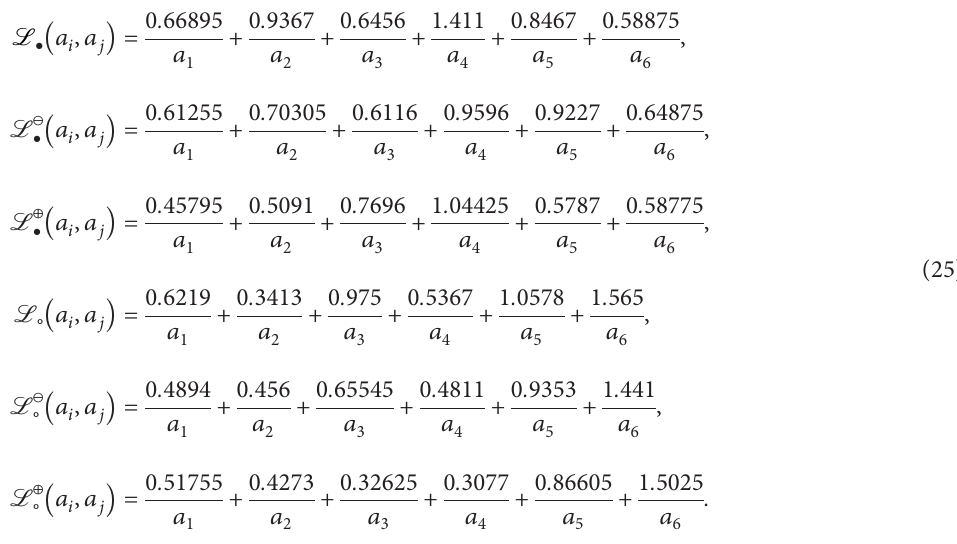
Figure 1 explains the comparisons between the lower approximation for the four models (i.e., 1-CVPFRLA, 2- CVPFRLA, 3-CVPFRLA, and 4-CVPFRLA). This figure clarifies that the 3-CVPFRLA is larger than the others. Figure 2 clarifies the comparisons between the upper approximation for the four models (i.e., 1-CVPFRUA, 2- CVPFRUA, 3-CVPFRUA, and 4-CVPFRUA). This figure shows that 3-CVPFRUA is smaller than the others. (1) Two documented issues with fuzzy c -neighborhoods are conquered by our presented methods. However, not all techniques can escape the obstacles that are not reflexive operators in fuzzy c -neighborhoods and that the lower approximations they describe are